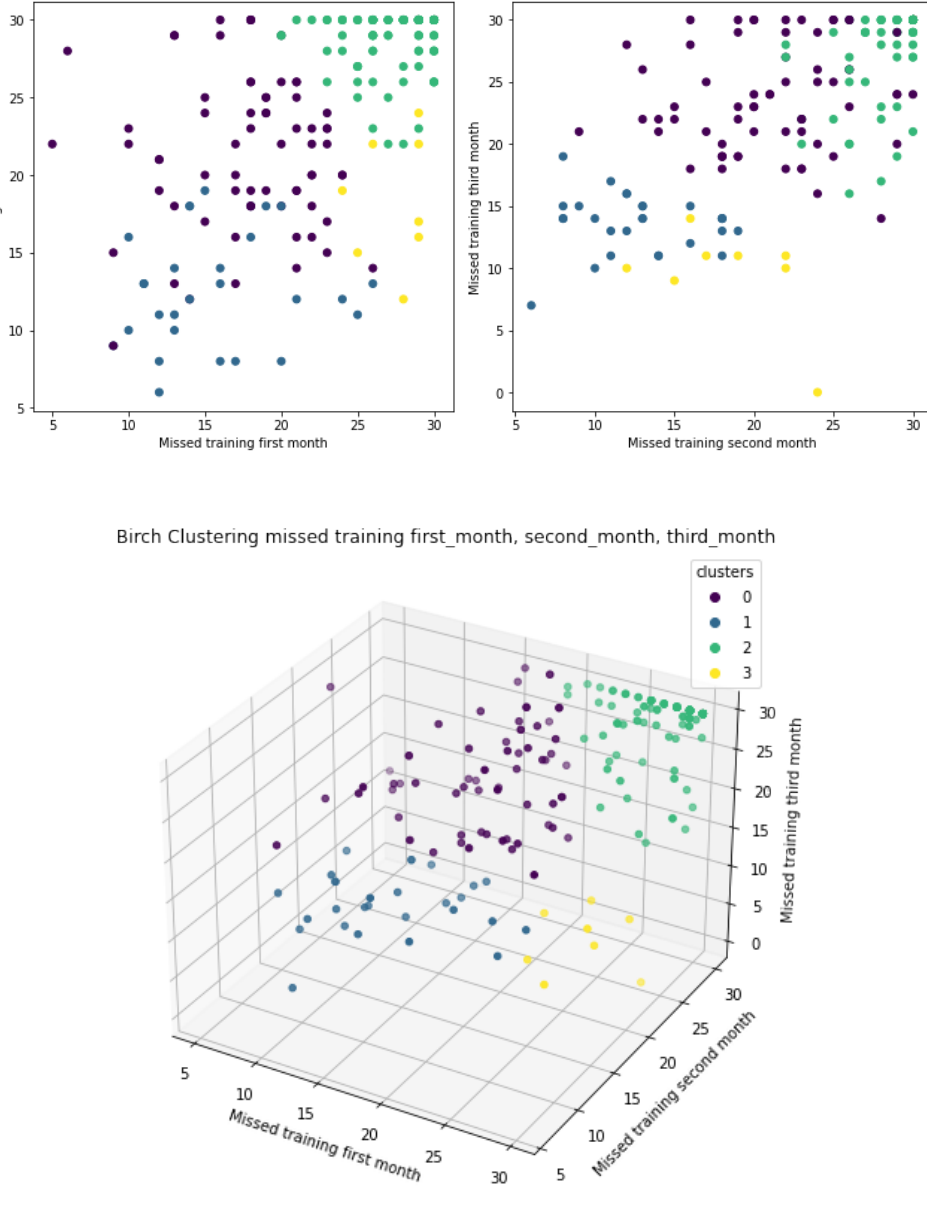
Figure 9. BIRCH clustering taking “missed first month”, “missed second month” and “missed third month” as